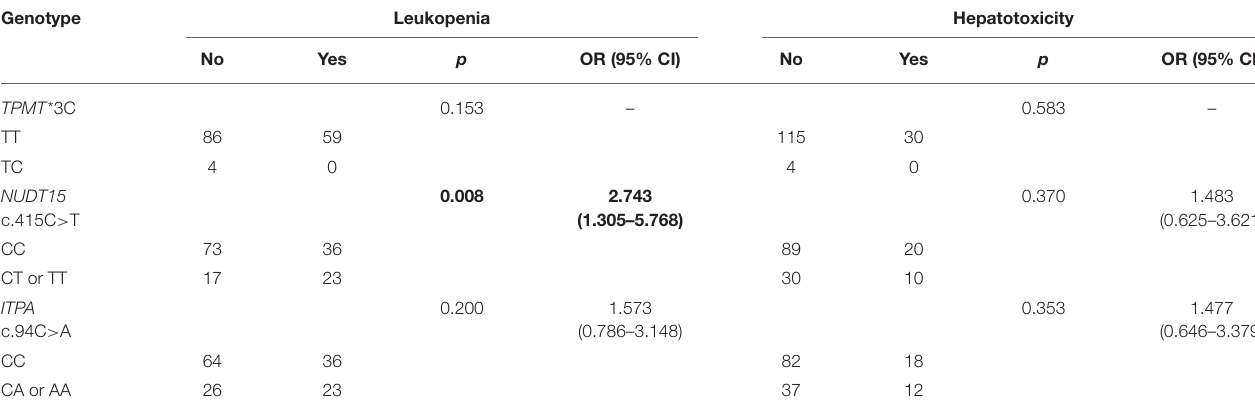
TABLE 2 | Associations between genetic variants and 6-MP toxicities. Genotype